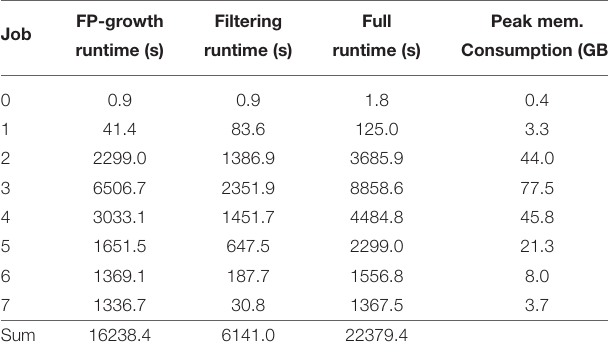
TABLE 2 | Workstation runtime and memory consumption of the implementation currently used in SPADE .